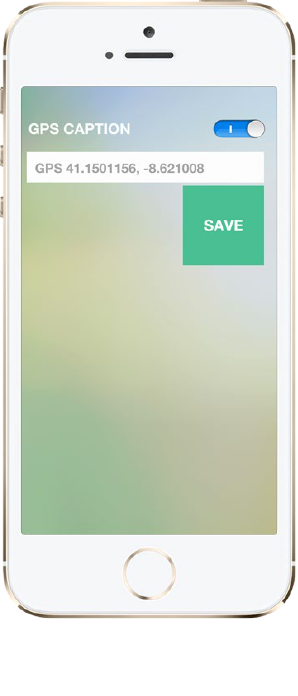
Fig. 7. U.I. input text screen